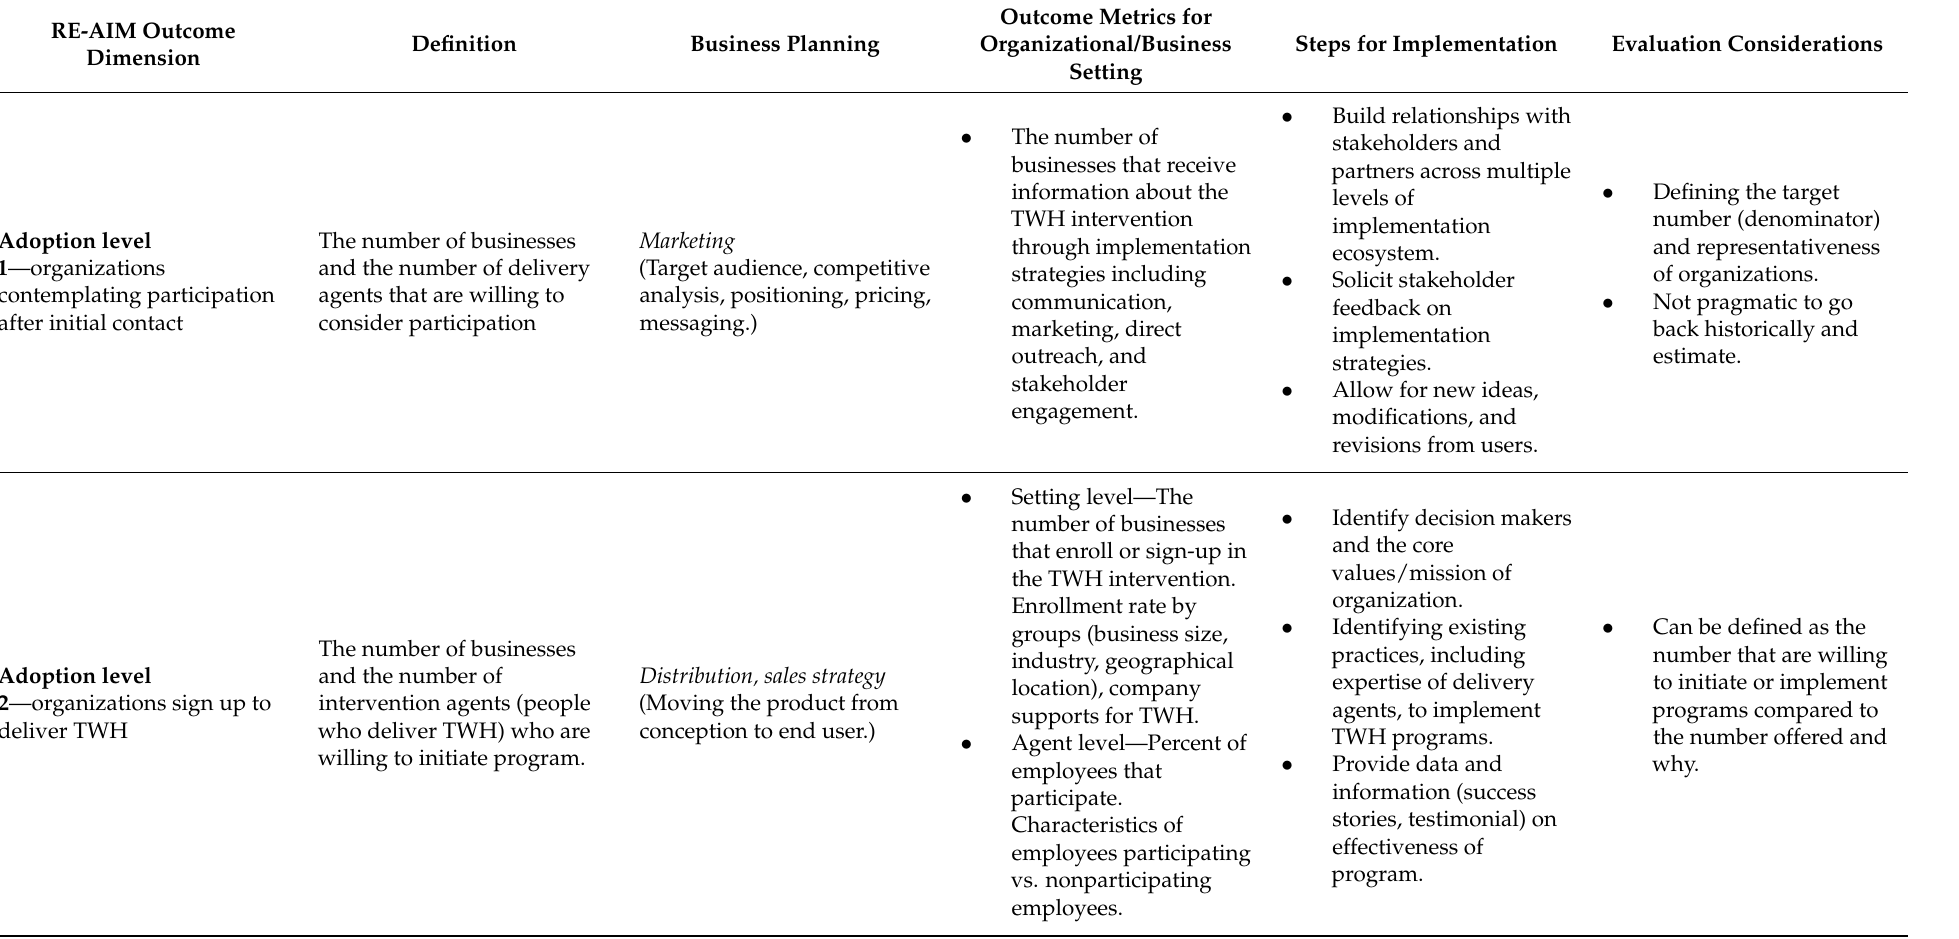
Table 1. Implementation outcome measures by RE-AIM component applied to organizational-level TWH